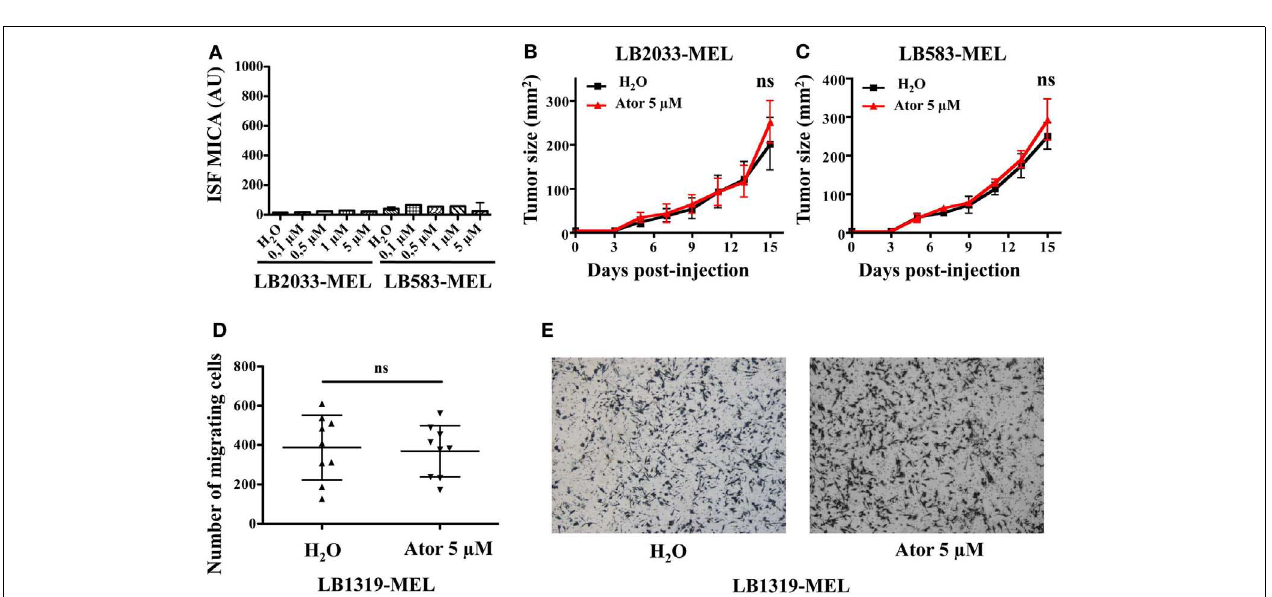
FIGUREA1 |Atorvastatin and lovastatin treatments of LB1319-MEL and BB74-MEL cells induce MICA membrane overexpression. LB1319-MEL cells were treated with increasing concentrations of atorvastatin and membrane MICA expression was analyzed by flow cytometry (A) . BB74-MEL cells were treated with 5 or 10 µ M atorvastatin for 48h (Ator) or untreated (H 2 O). MICA membrane expression was analyzed by flow cytometry (B) and